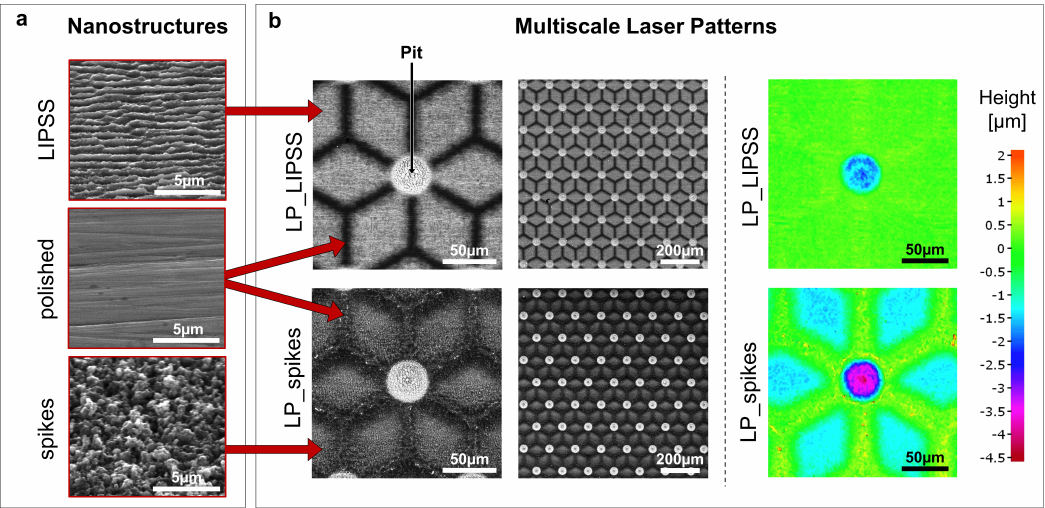
Figure1. Nanostructures(LIPSSorspikes)andmultiscalelaserpatterns(LP)producedbyafemtosecond laser. ( a )Scanningelectronmicroscope(SEM)micrographsofpolishedsurfacesandlaser-nanostructured surfaces with LIPSS or spikes (tilt 45 ◦ ). ( b ) SEM micrographs and focus variation microscopy of laser-patterned surfaces. LP_LIPSS and LP_spikes with a mix of polished and nanostructured